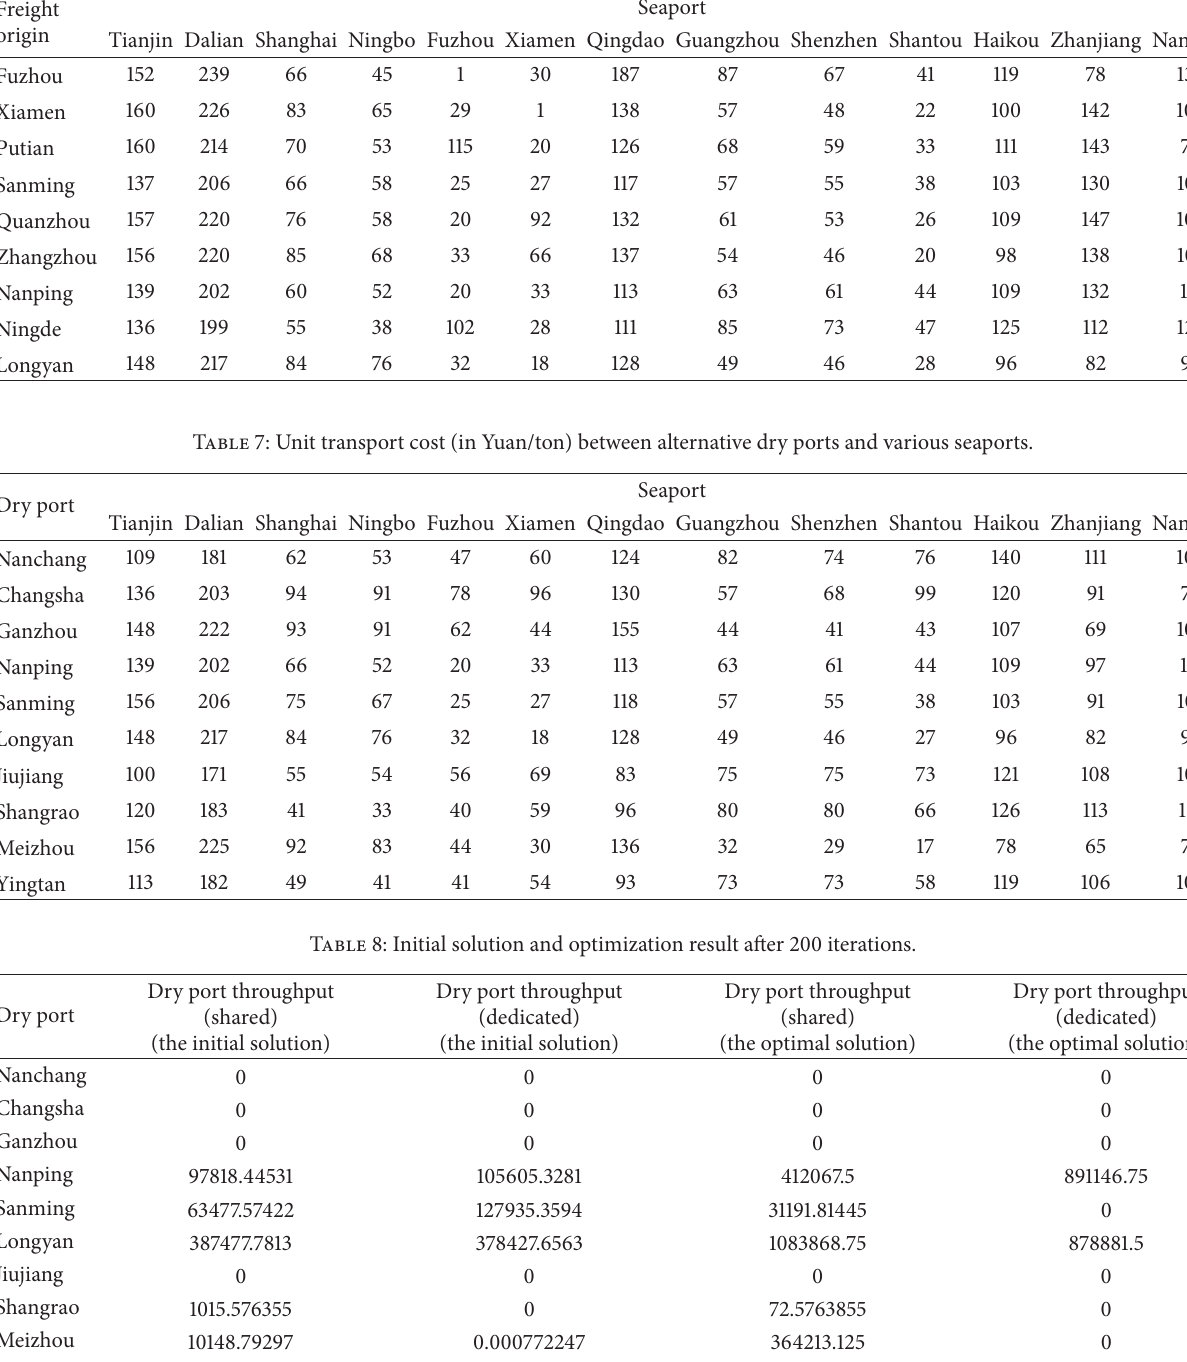
Table 6: Unit transport cost (in Yuan/ton) between cities in Fujian province and various seaports.